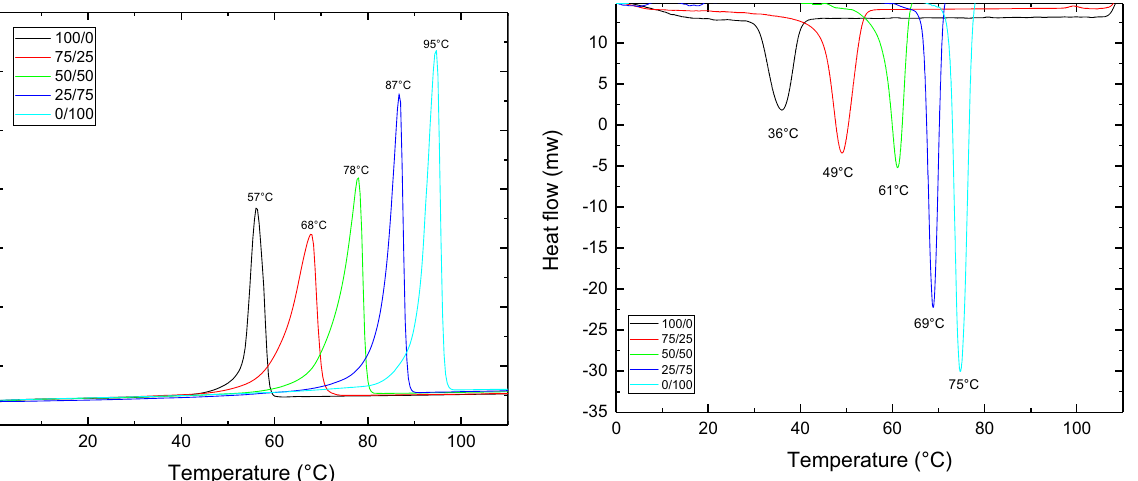
Figure 5: DSC heating curves of MW - synthesized copolyesters CL – PDL.